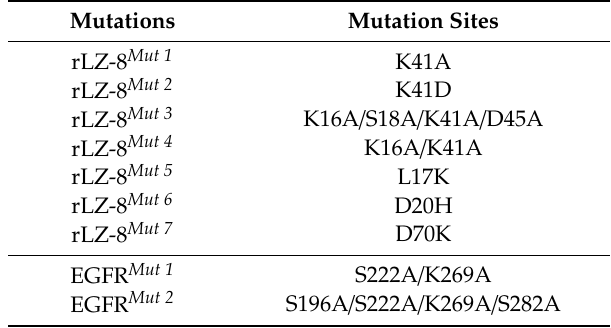
Table 1. Mutants of rLZ-8 and Epidermal Growth Factor Receptor